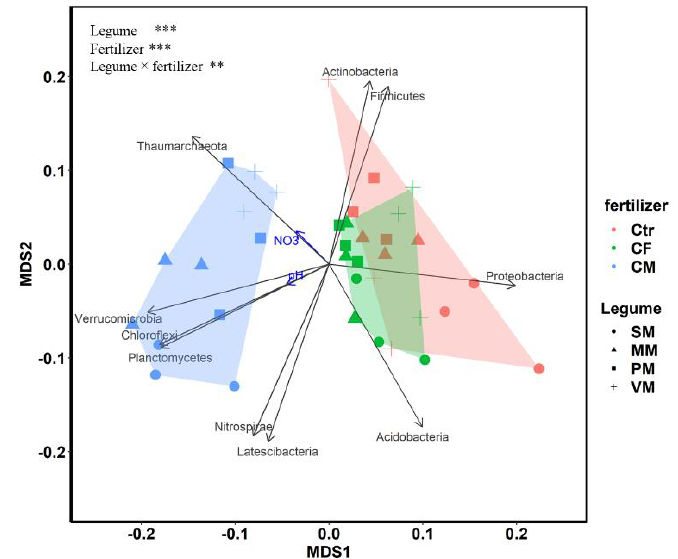
Figure 2. Nonmetric multidimensional scaling plot based on Bray–Curtis dissimilarity (stress = 0.158).